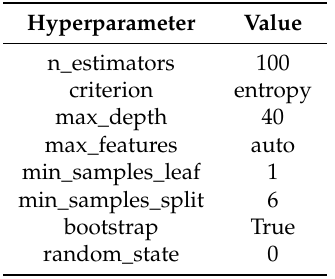
Table 8. Hyperparameters of Random Forest model.